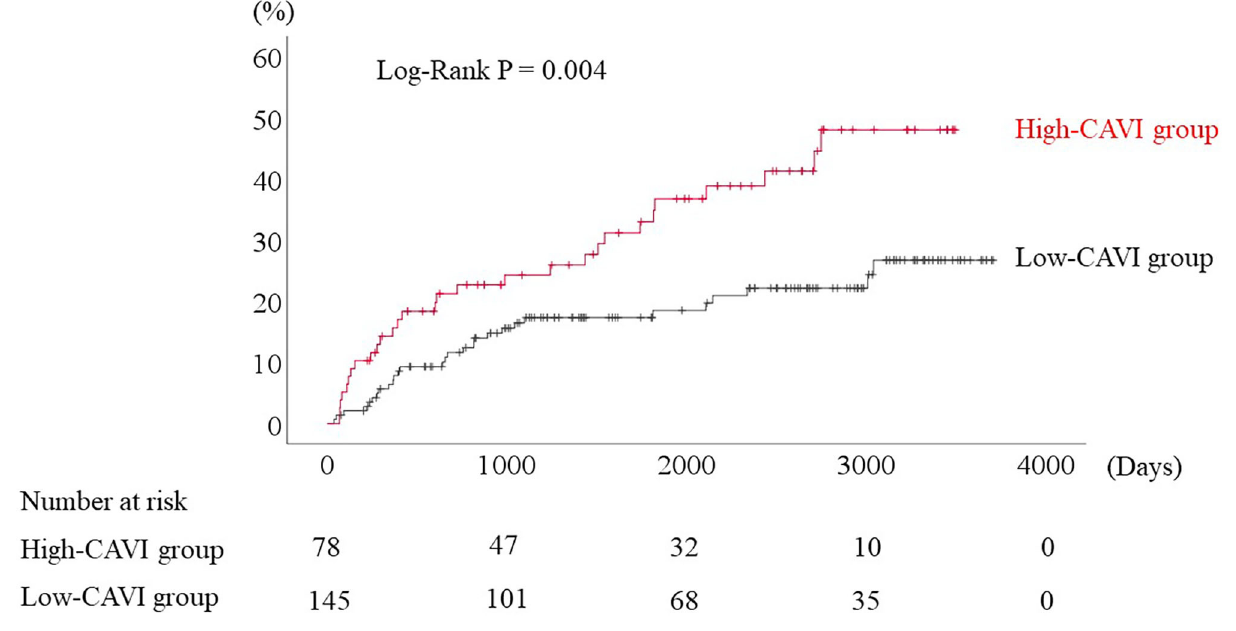
high CAVI did not fully predict ischemic coronary events and all-cause mortality in the multivariate Cox proportional hazard analysis ( Tables 4 , 5 ). Furthermore, in the subgroup analysis for predicting cardiac events ( Table 6 ), there was no significant interactions between prognostic impact of CAVI and both sex ( P = 0.704), age ( P = 0.291), and LVEF ( P =